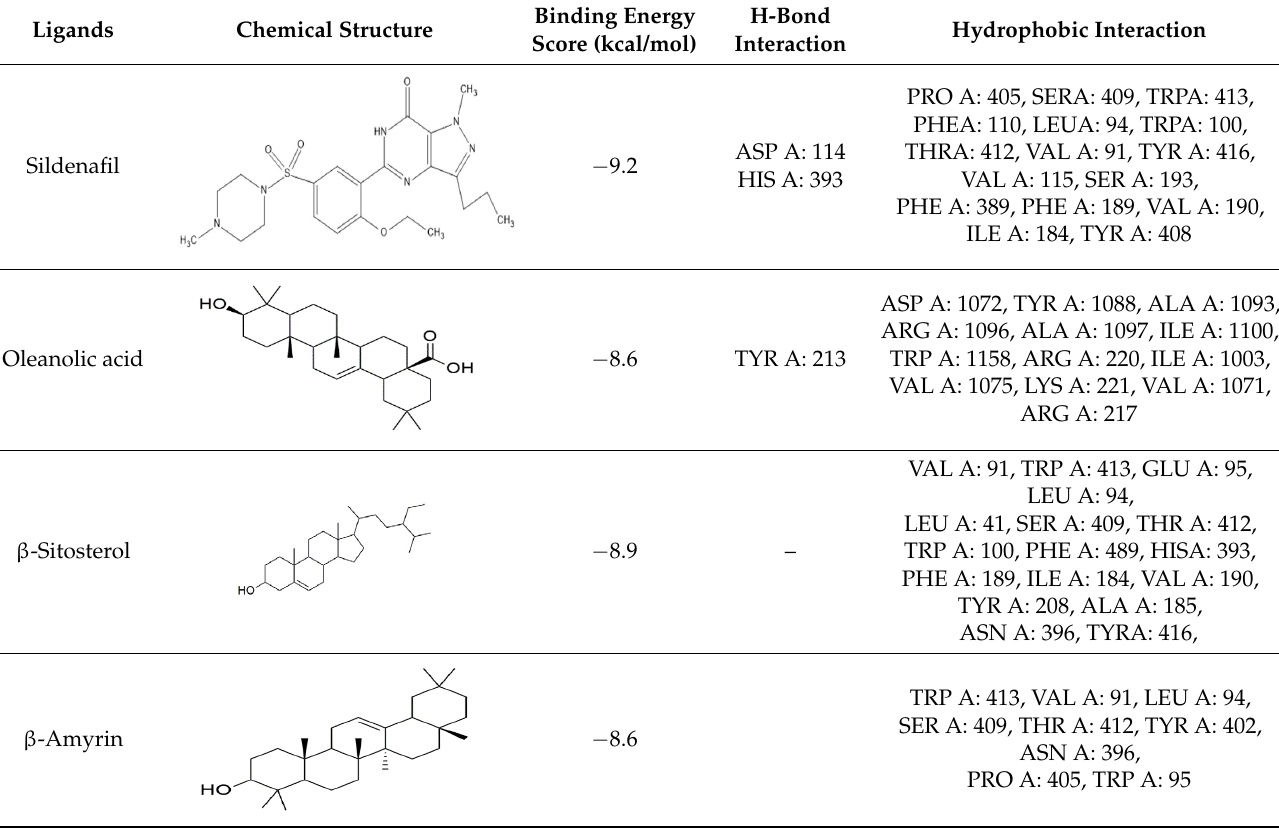
Table 2. Summary of the selected constituents and the reference compound sildenafil into the active site of dopamine R2, chemical structures, AutoDock vin docking scores, hydrogen bond interac- tions, and close contact residues.